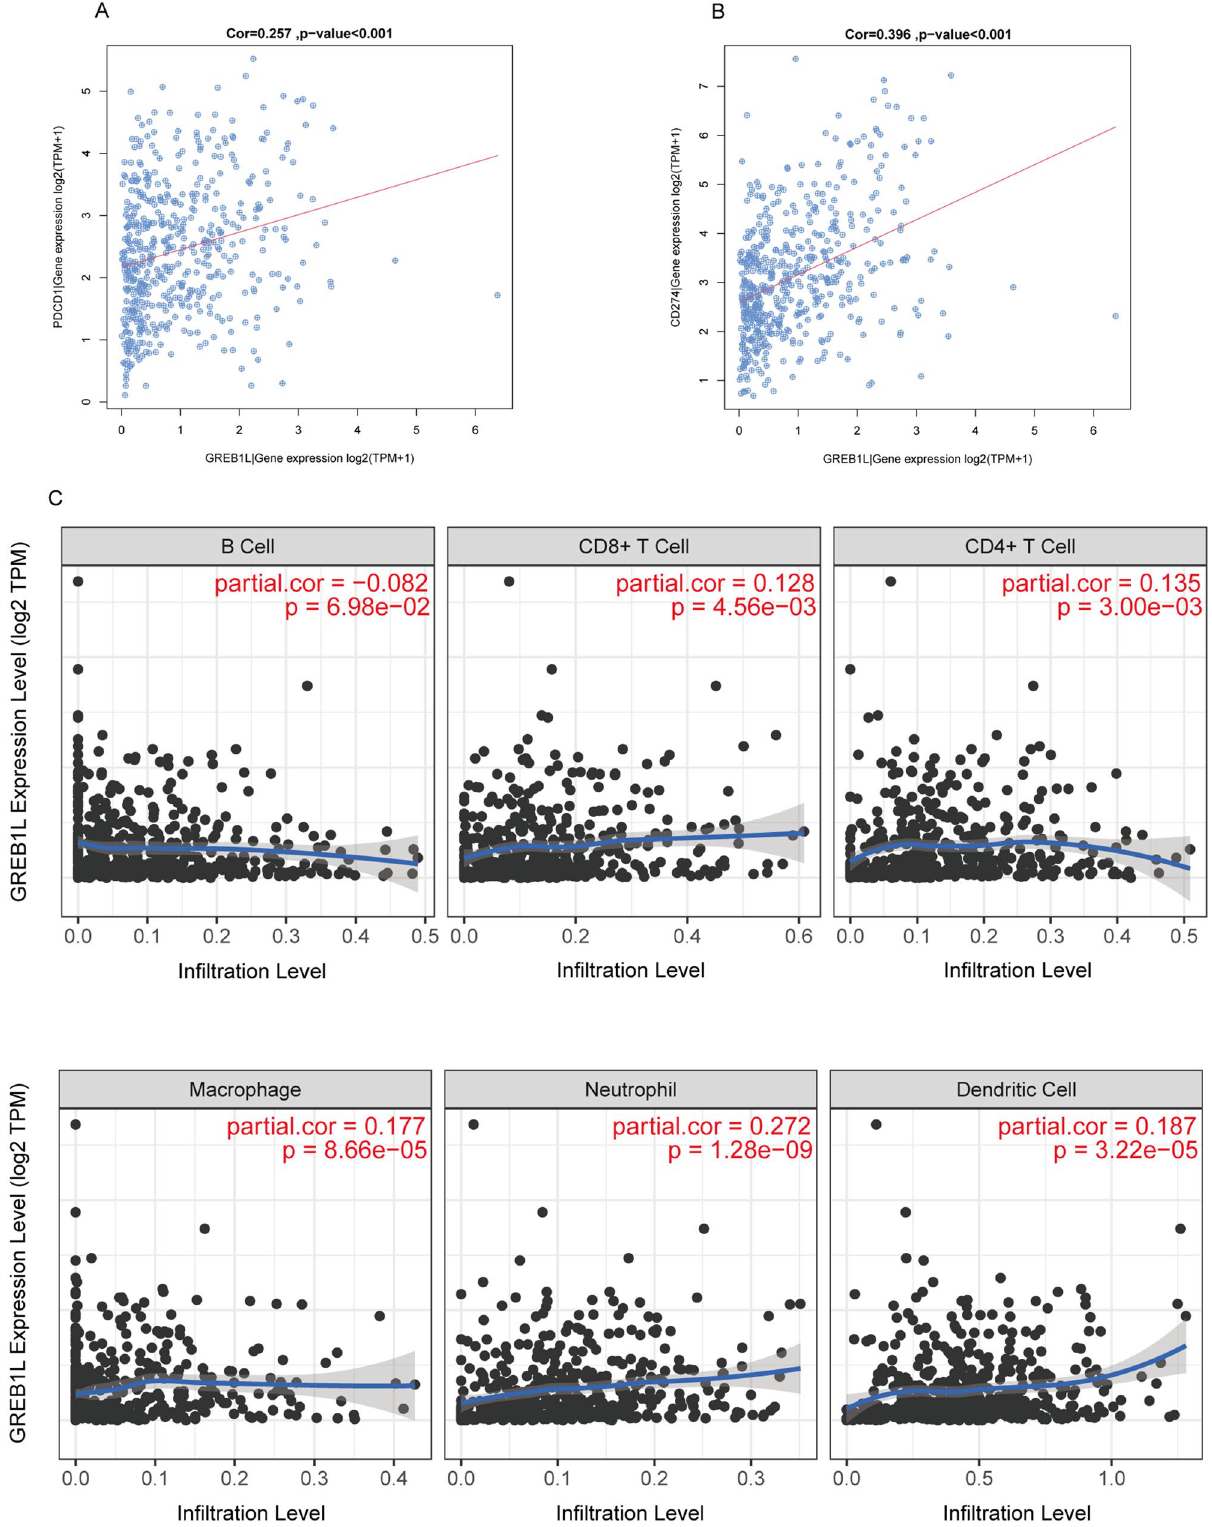
Figure 8. Correlation between PDCD1 (PD1), CD274 (PD-L1), immune cells infiltration, and GREB1L in LUAD. ( A ) The correlation of GREB1L expression and PDCD1 expression. ( B ) The correlation of GREB1L expression and CD274 expression; ( C ) GREB1L expression significantly positively correlated with the infiltration of CD8+ T cell, CD4+ T cell, macrophage, neutrophil, and dendritic cell, but not with the infiltration of B cell. (software: TIMER, version: TIMER1.0, URL: https:// cistr ome. shiny apps. io/